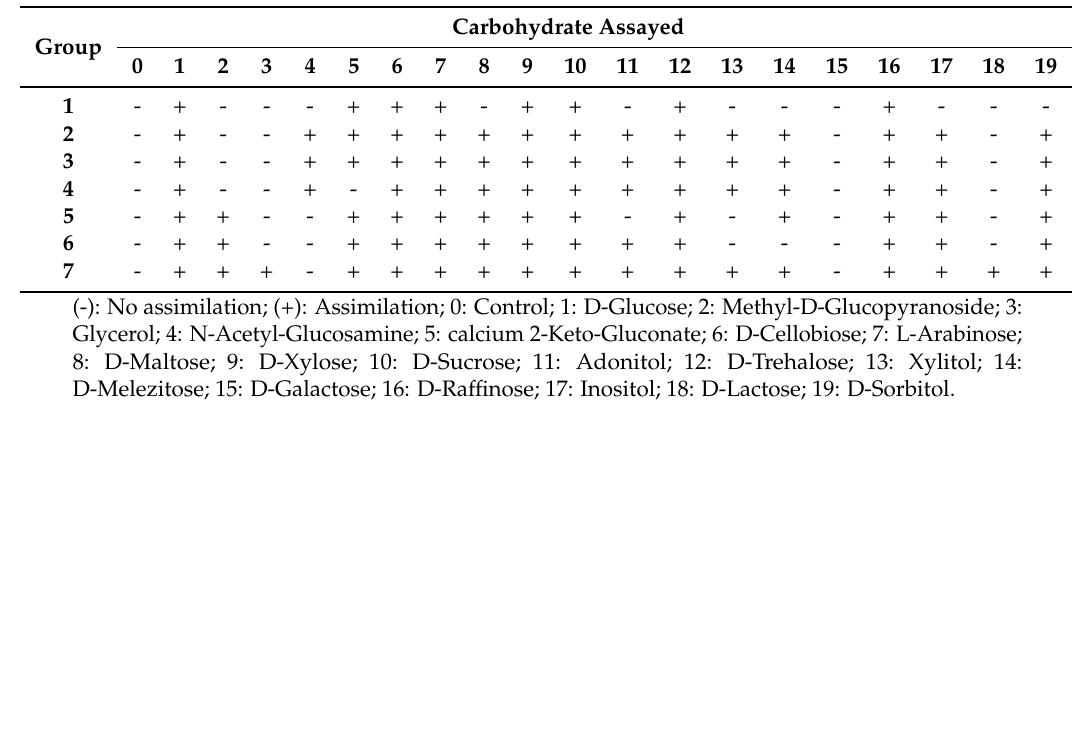
Table 2. API C AUX assays for different groups of